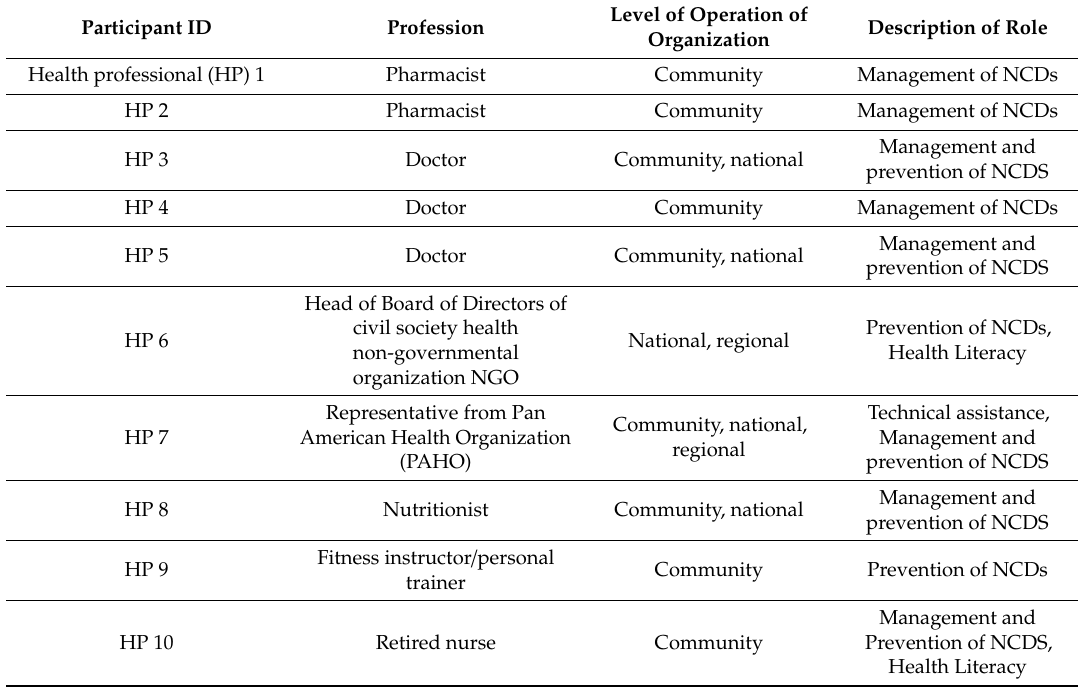
Table 1. Description of key